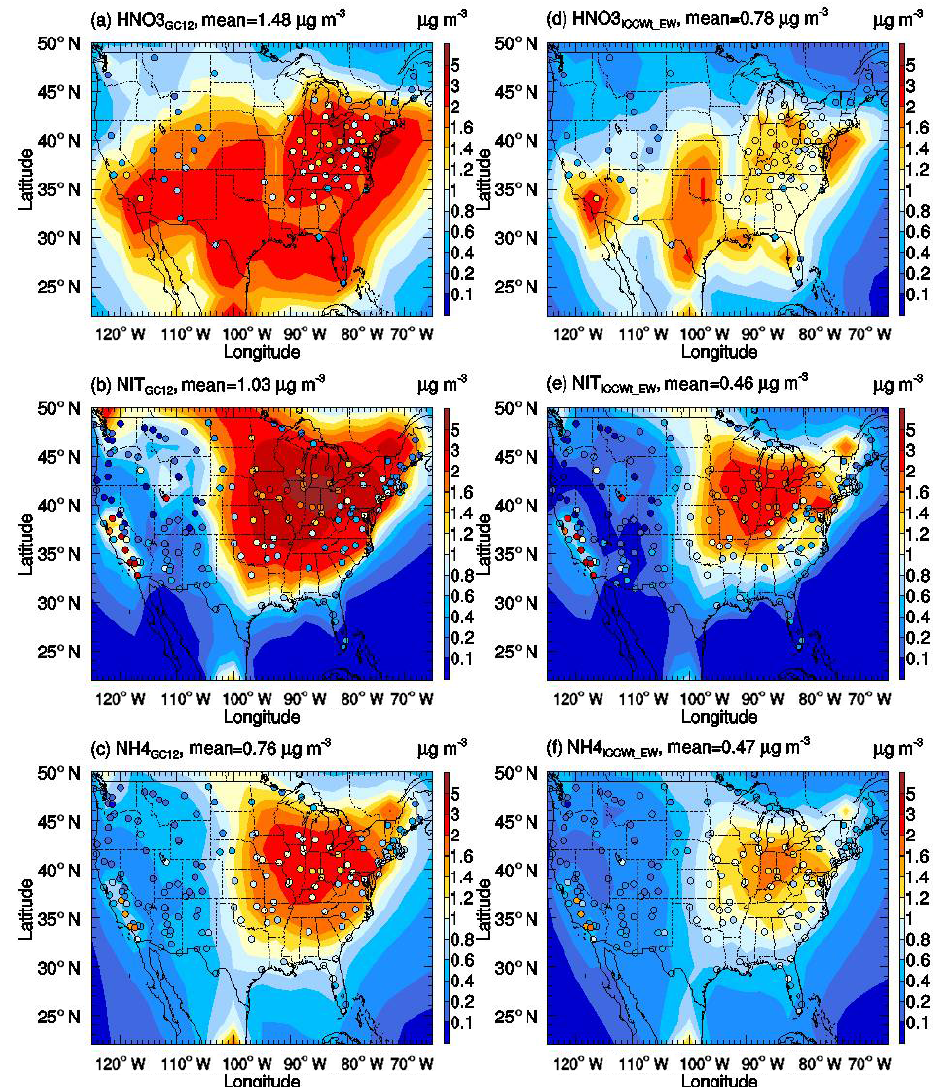
Figure 3. Horizontal distributions of surface-layer nitric acid, nitrate, and ammonium simulated by the GC12 case (a–c) and the ICCW t _EW case (d–f) . Filled circles are annual mean surface mass concentrations observed at CASTNET, IMPROVE, and CSN for corresponding